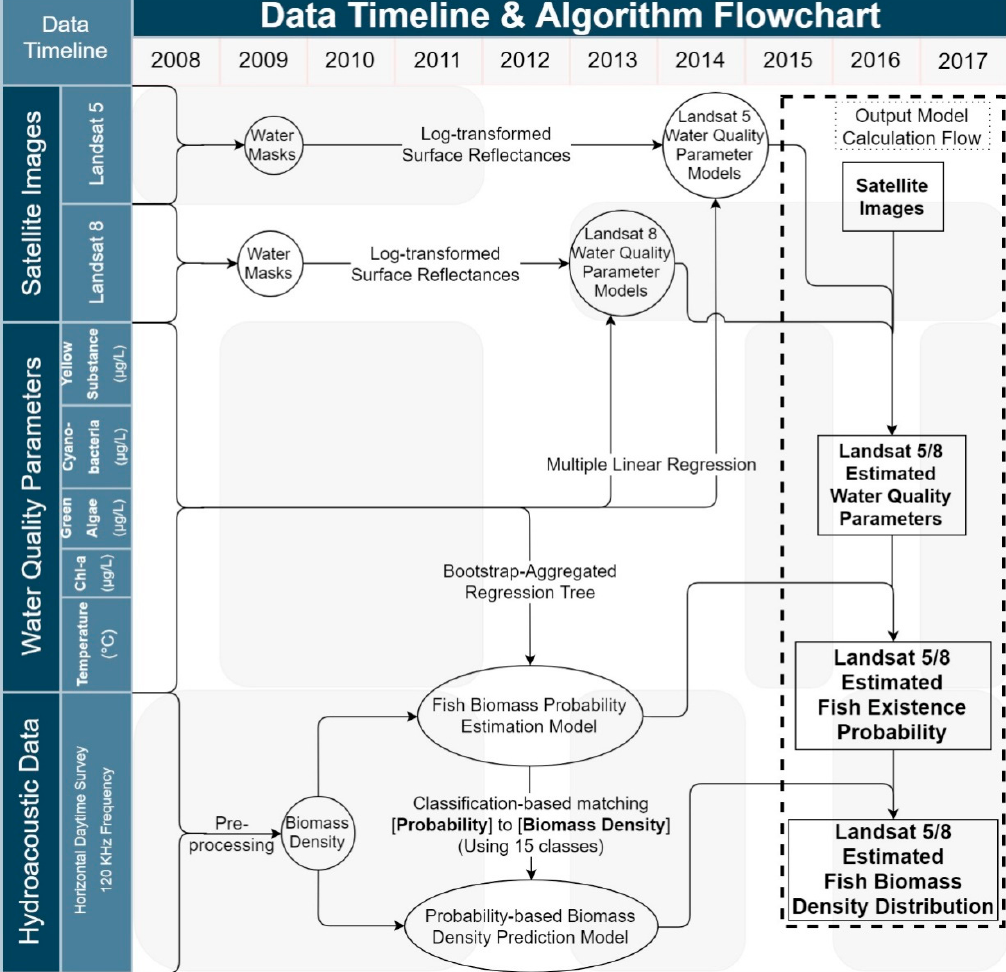
Figure 1. Data timeline and algorithmic methodology flowchart. Transparent shading represents data availability per year and dataset, while the dashed line highlights the primary output workflow algorithm, utilizing the individually derived models.